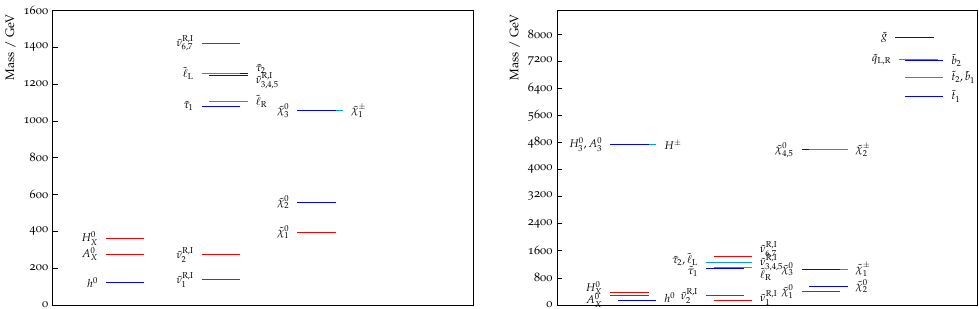
Figure 4 . The SUSY mass spectrum of a typical A X -resonance model point. The right panel shows the full spectrum and the left hand panel is zoomed into the mass scale between 0 to 1.6 TeV. The red lines present the particles beyond the MSSM while blue lines represent the MSSM particles. Note that the cyan lines represent degenerate MSSM